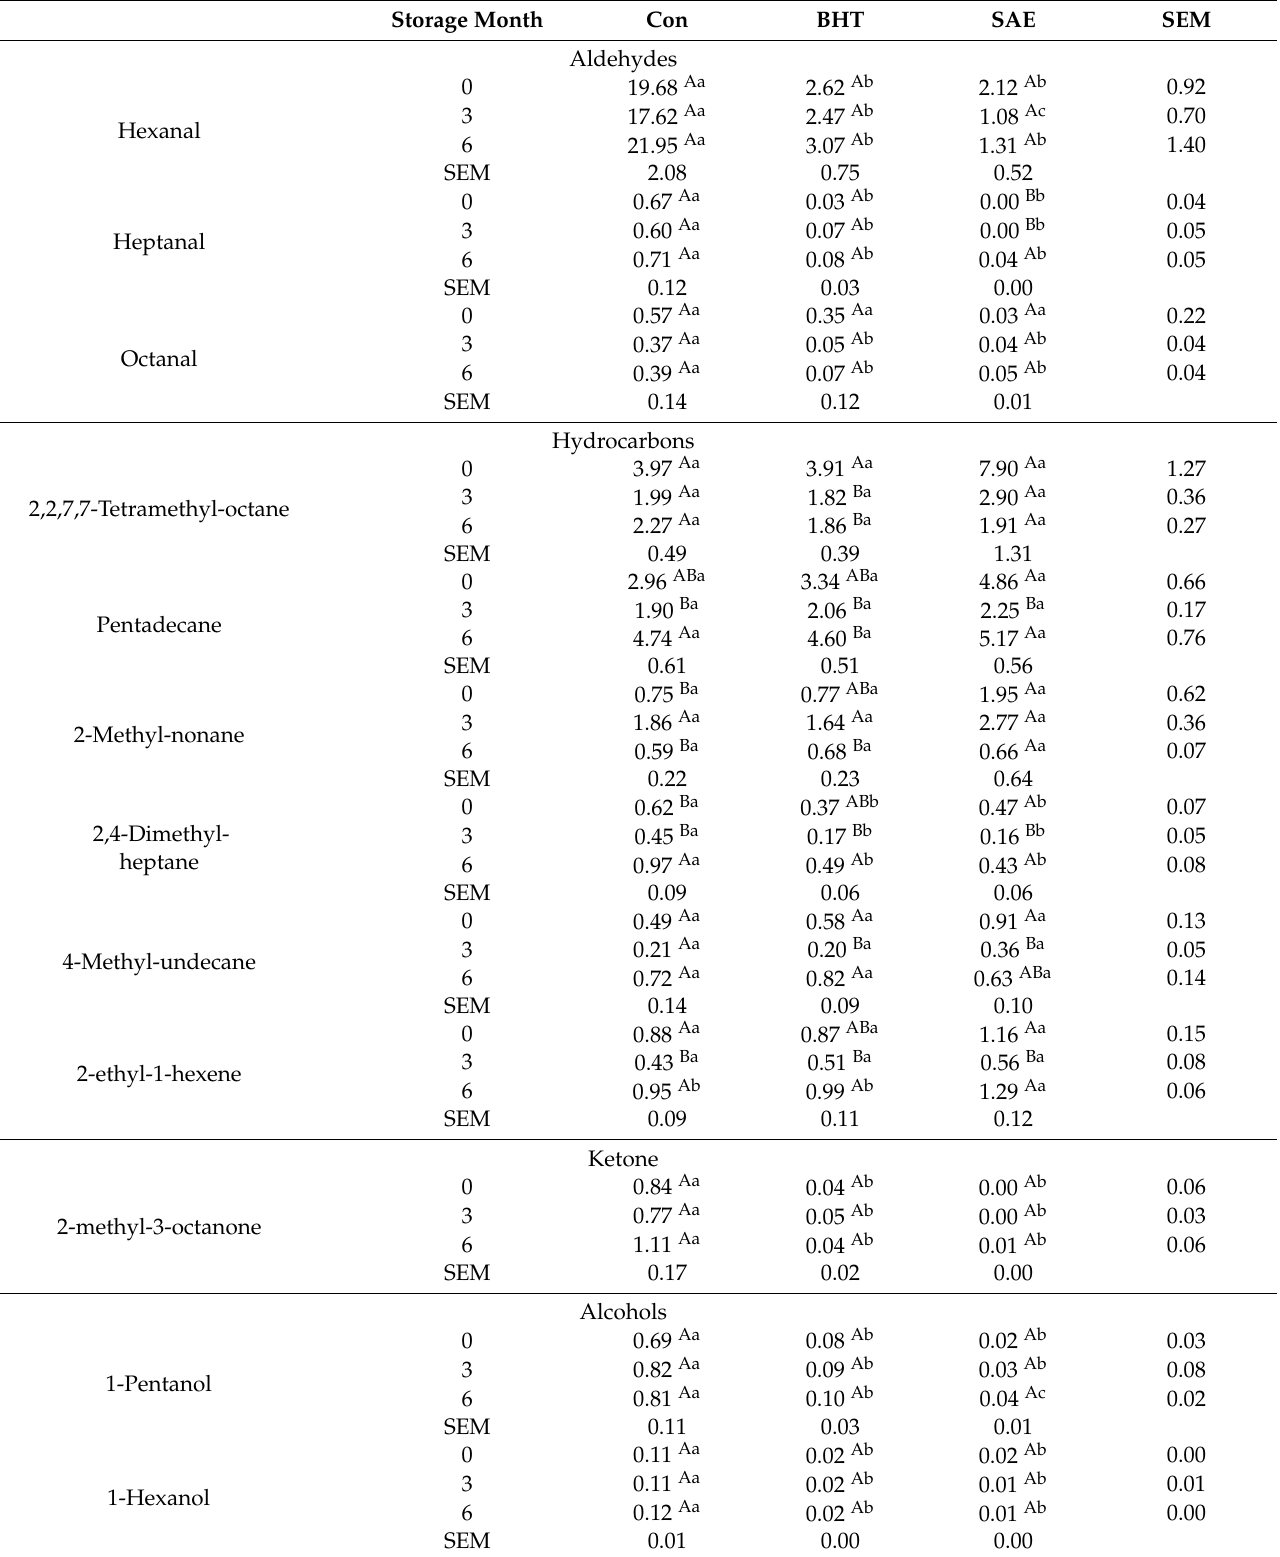
Table 2. Volatile compounds of cooked ground beef with different antioxidant additives at frozen